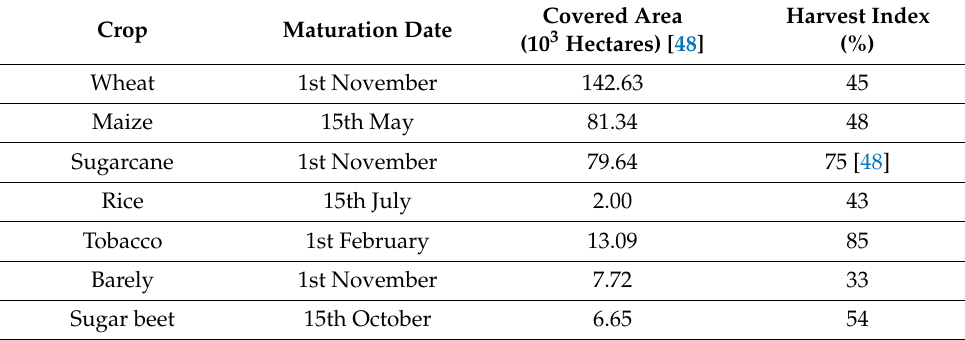
Table 2. Crop characteristics of Peshawar Basin,